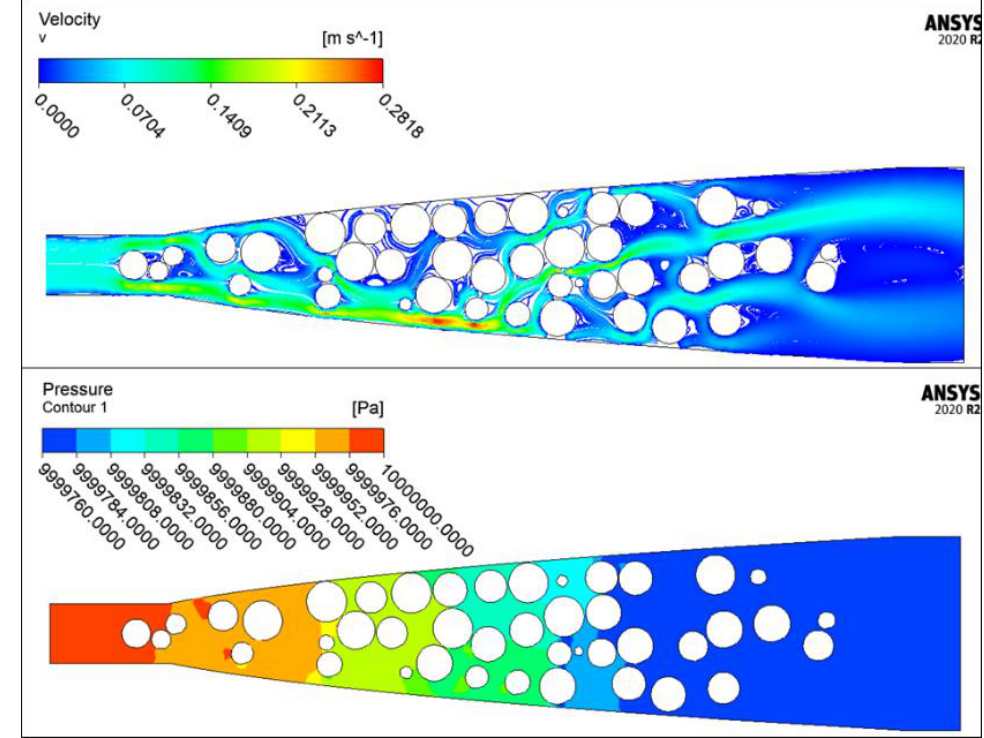
Figure 15. Velocity and pressure distribution within the fracture.